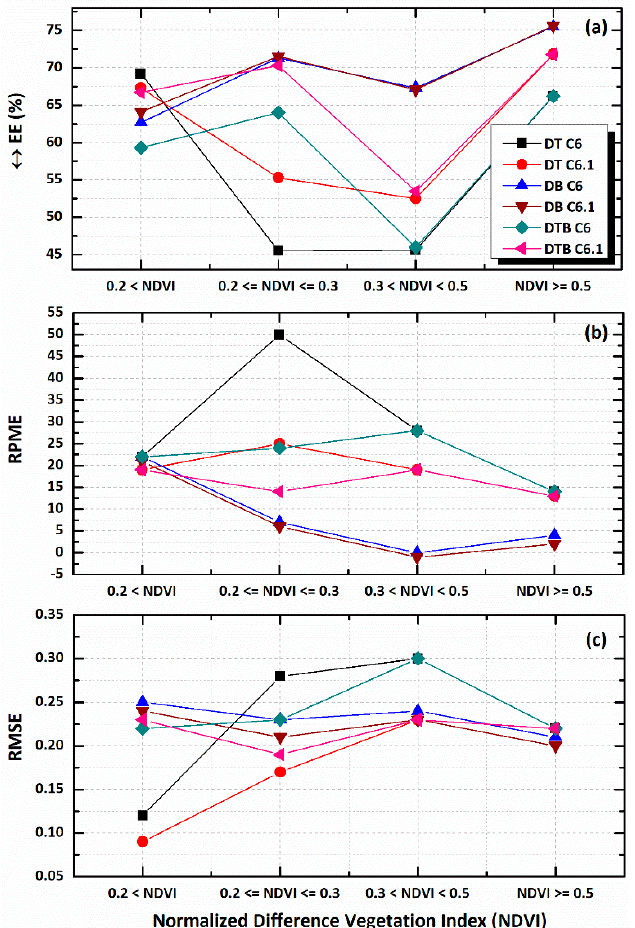
Figure 8. A trend of the percentage of retrievals ↔ EE ( a ), RMSE ( b ), and RPME ( c ) in AOD retrievals over diverse vegetated surfaces of the BTH region.